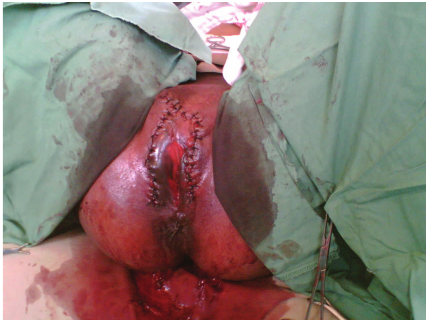
Figure 1: Patient “A” placed in dorsal lithotomy position revealing giant condyloma completely covering vulva.